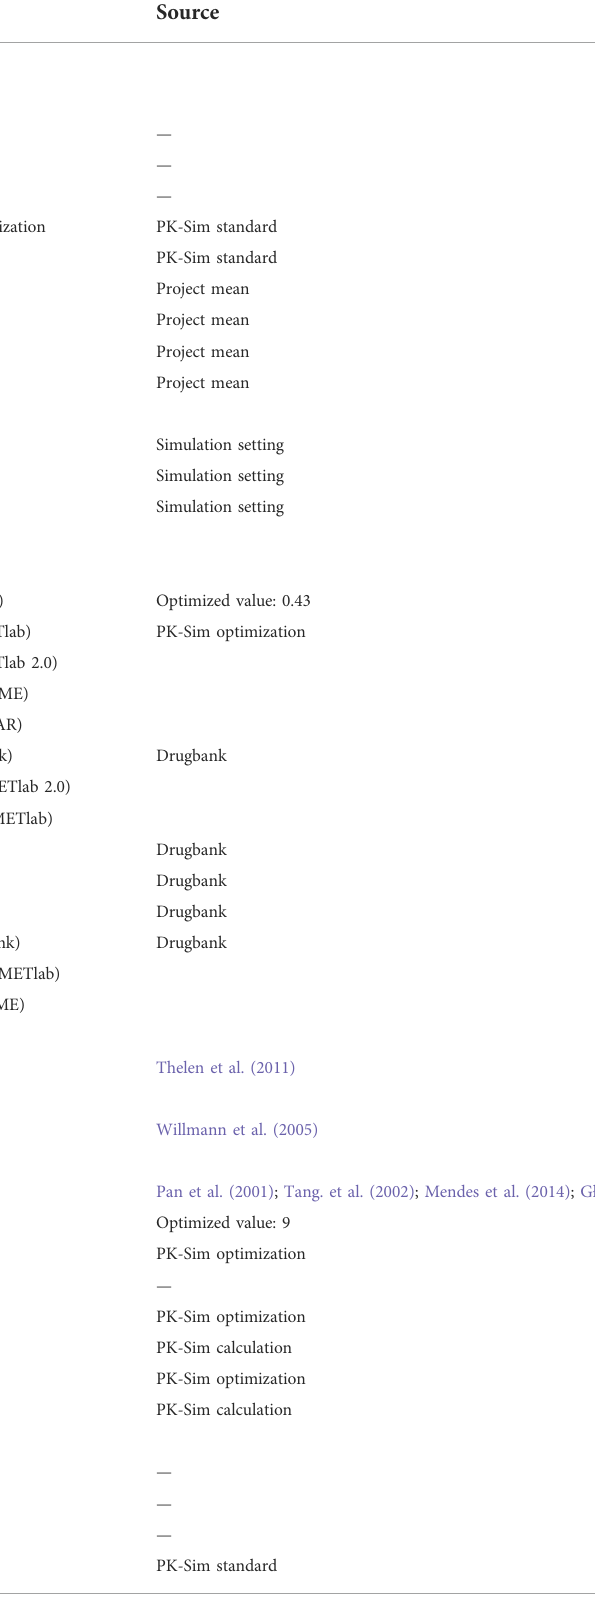
TABLE 1 Parameters required for PBPK model